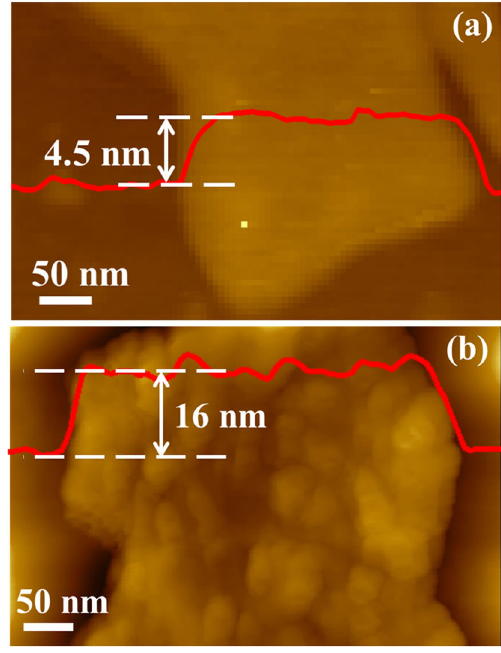
Figure 2. AFM images of ( a ) Nb 2 O 5 nanosheets and ( b ) TiO 2 @Nb 2 O 5 composites.